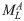
Macroscopic states and Boltzmann weights for cAMP binding to CRP.(A) Within the MWC model, cAMP (purple circles) may bind to a CRP subunit in either the active (dark green) or inactive (light green) state. MLA and MLI represent the dissociation constants of the left subunit in the active and inactive states, respectively, while MRA and MRI represent the analogous dissociation constants for the right subunit. [M] denotes the concentration of cAMP and ϵ represents the free energy difference between each subunit’s inactive and active states with β=1kBT. ϵintA and ϵintI represent a cooperative energy when two cAMP are bound to CRP in the active and inactive states, respectively. (B) The KNF model assumes that the two CRP subunits are inactive when unbound to cAMP and transition to the active state immediately upon binding to cAMP. The parameters have the same meaning as in the MWC model, but states where one subunit is active while the other is inactive are allowed.